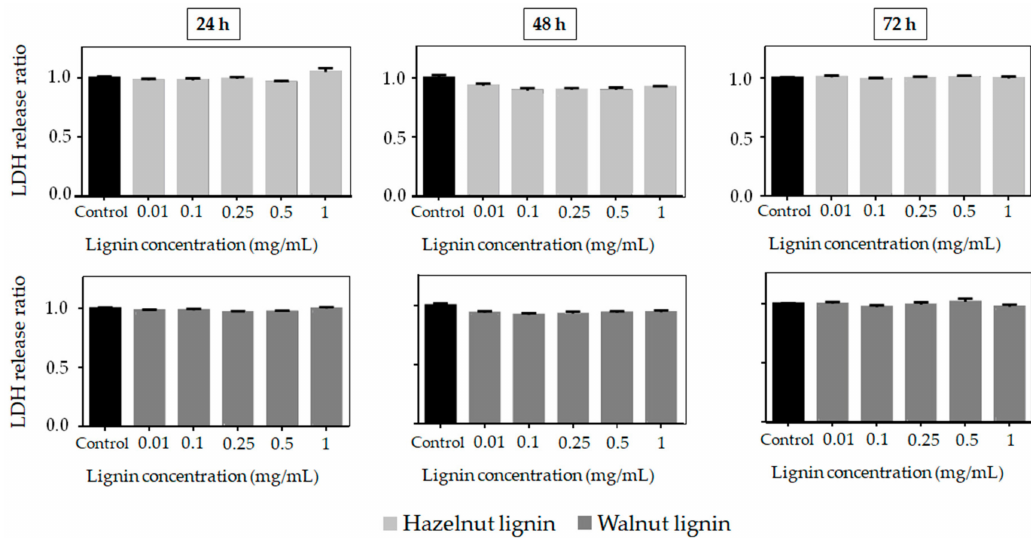
Figure 3. Cell death ratio (based on LDH enzyme release measurement) of murine fibroblast cell line at di ff erent concentrations of lignin at 24 h, 48 h and 72 h of